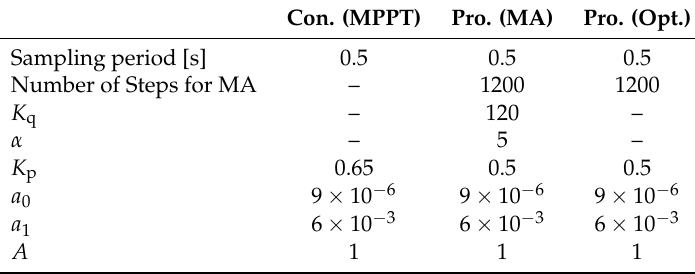
Table 5. Controller parameters of wind generator (WG) and